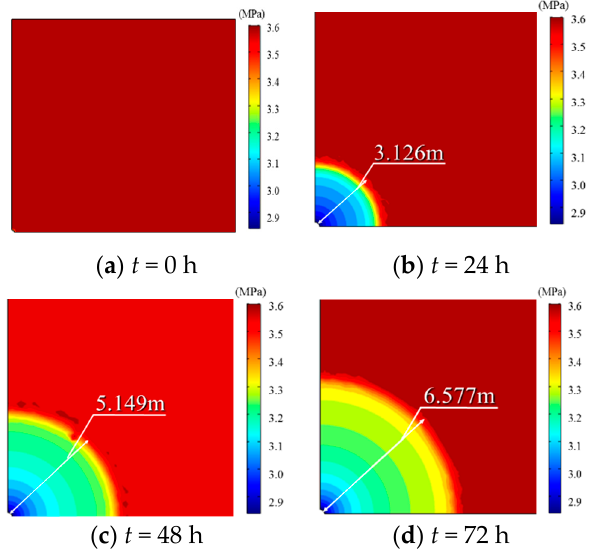
Figure 10. Spatial evolution of the average pore pressure of strata at different times. ( a ) Average pore pressure in the reservoir at t = 0 h; ( b ) Average pore pressure in the reservoir at t = 24 h; ( c ) Average pore pressure in the reservoir at t = 48 h; ( d ) Average pore pressure in the reservoir at t = 72 h.